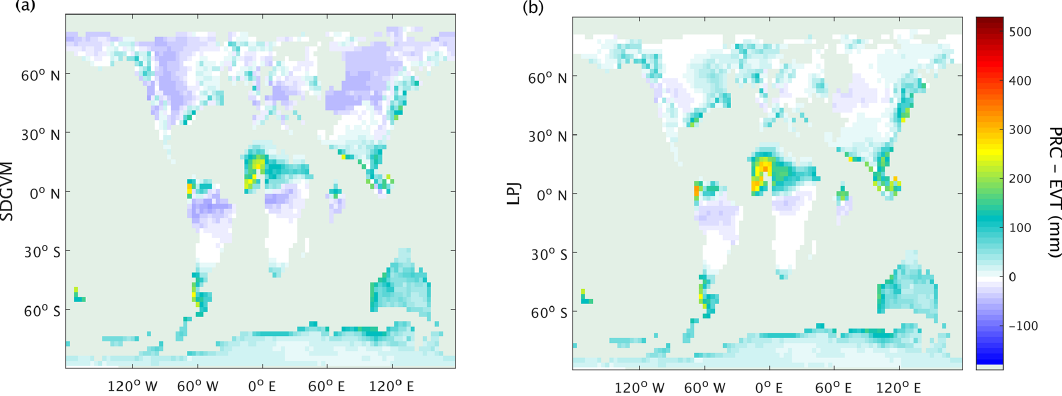
Figure 11. June–July–August mean precipitation minus evapotranspiration for the Eocene climate, using evapotranspiration from (a) SDGVM or (b)